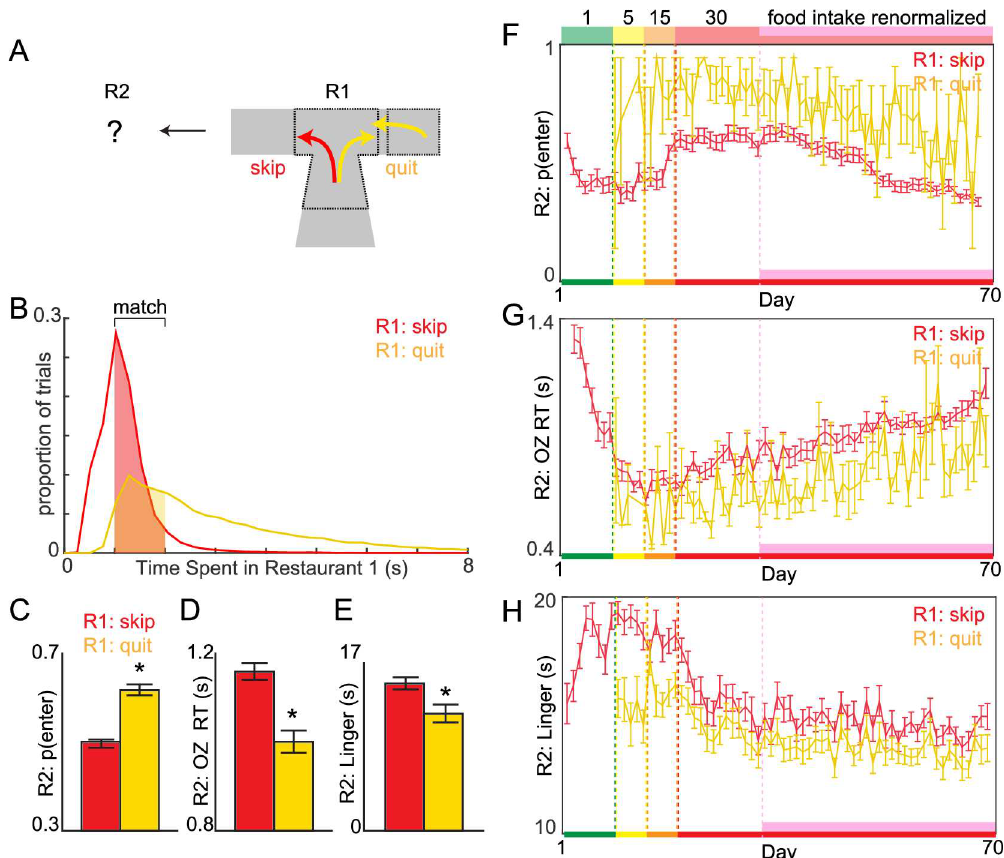
Fig 6. Regret-like sequence effects following change-of-mind wait zone reevaluations. (A) Following either a skip or enter- then-quit decision in R1, we characterized behaviors on the subsequent trial in R2. (B) Distribution of time spent in R1 from offer onset until a skip decision (OZ time) or quit decision (OZ time plus wait zone time) was made. To control for the effects of differences in time spent skipping versus entering-then-quitting in R1 on behavior in Restaurant 2, we compared trials matched for resource depletion between conditions. (C-D) Data averaged across the 1–30 s offer block. (C) Probability of entering an offer in R2 after skipping versus quitting in R1. (D) OZ RT in R2 after skipping versus quitting in R1. (E) Time spent consuming an earned pellet and lingering at the reward site in R2 after skipping versus quitting in R1. (F-H) Postskip versus post-enter-then-quit sequence data across the entire experiment from (C-E), respectively. Data are presented as the cohort’s ( N = 31) means ( ± 1 SE). Color code on the x-axis in (F-H) reflects the stages of training (offer cost ranges denoted from 1 to the number on the top of panel F). Vertical dashed lines (except pink) represent block transitions. (cid:3) indicate significant difference between skip versus quit conditions. Data available as a supplemental file. OZ, offer zone; R1, restaurant 1; R2, restaurant 2; RT, reaction time.